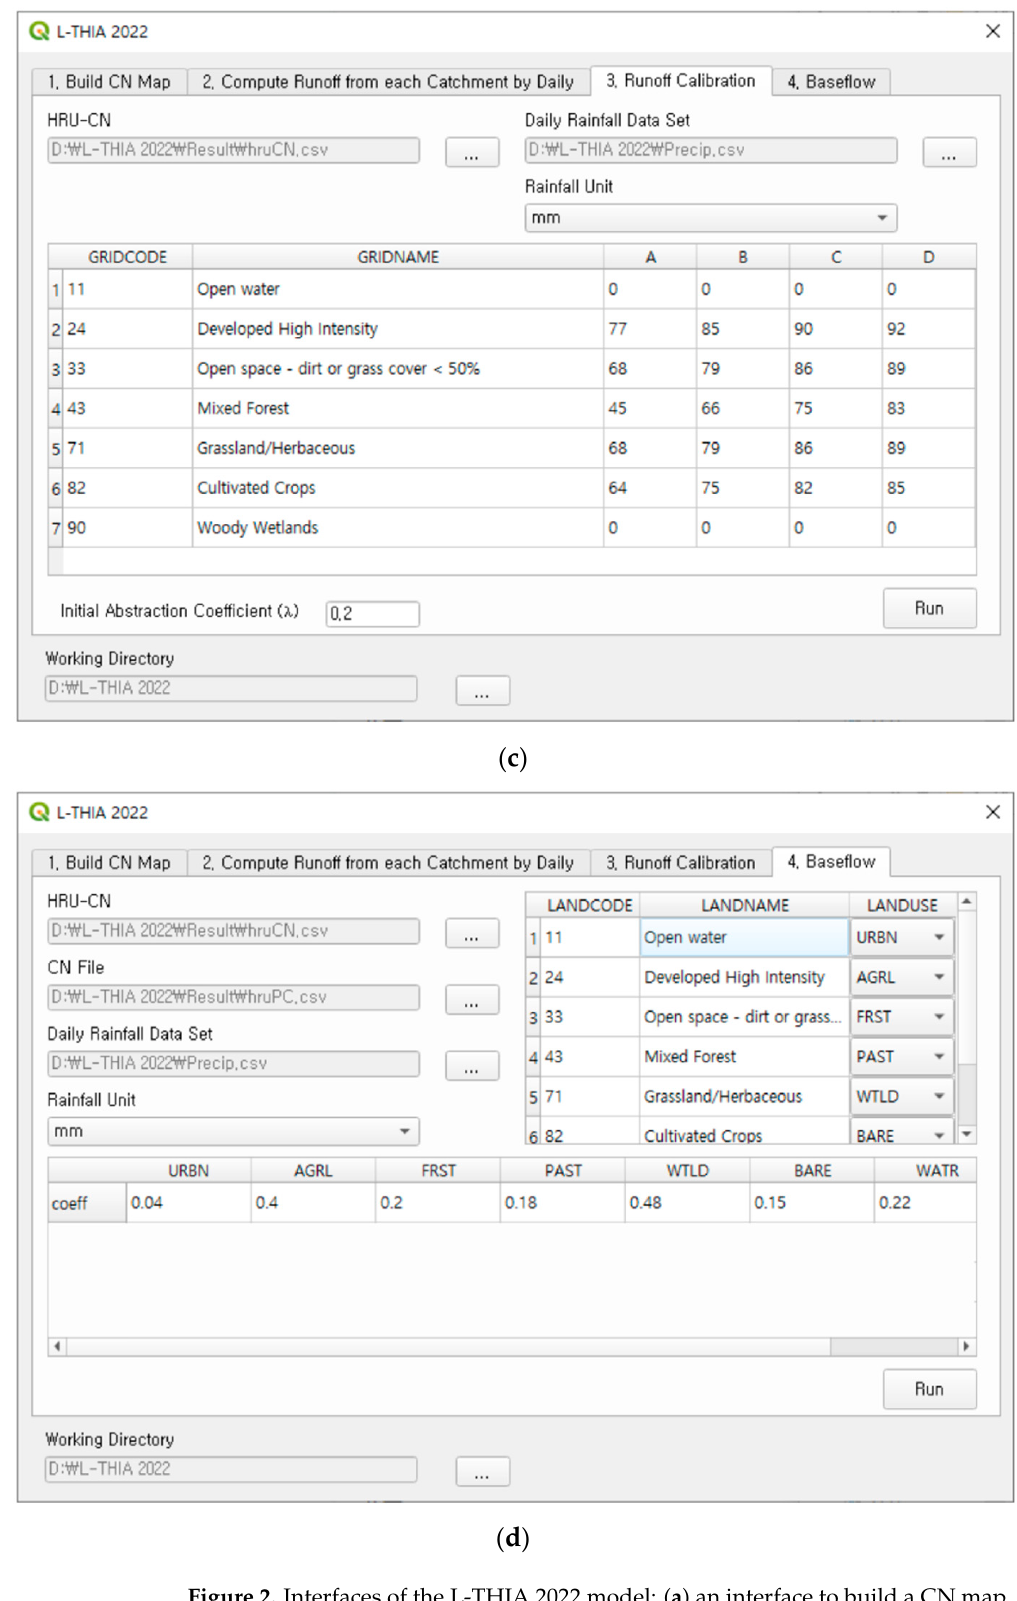
Figure 2. Interfaces of the L-THIA 2022 model: ( a ) an interface to build a CN map, ( b ) an interface to compute daily direct runoff, ( c ) an interface to update CNs, and ( d ) an interface to compute monthly baseflow.